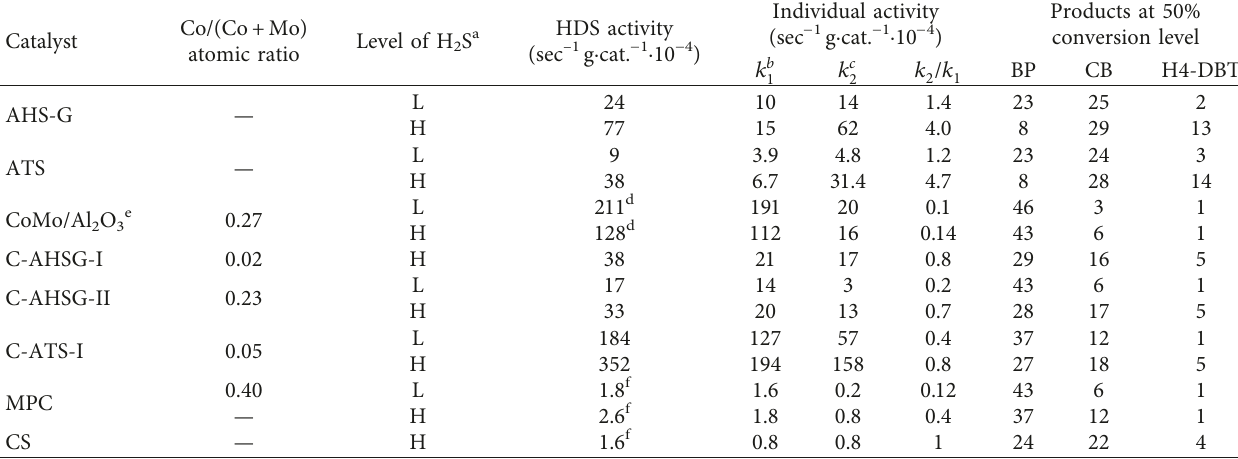
Table 1: Activities of the catalysts towards the HDS of dibenzothiophene.